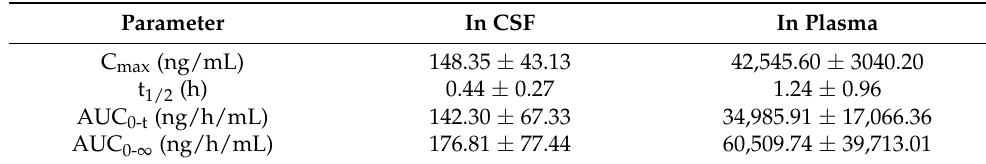
Figure 4. Concentration–time curves of 5-CQA after tail vein injection of 50 mg/kg 5-CQA. ( A ) Concentration–time curve of rat plasma; ( B ) concentration–time curve of rat CSF. Table 4. The main pharmacokinetic profile of 5-CQA in the plasma and CSF of rats after vein injection of a single dose of 50 mg/kg ( n = 5).